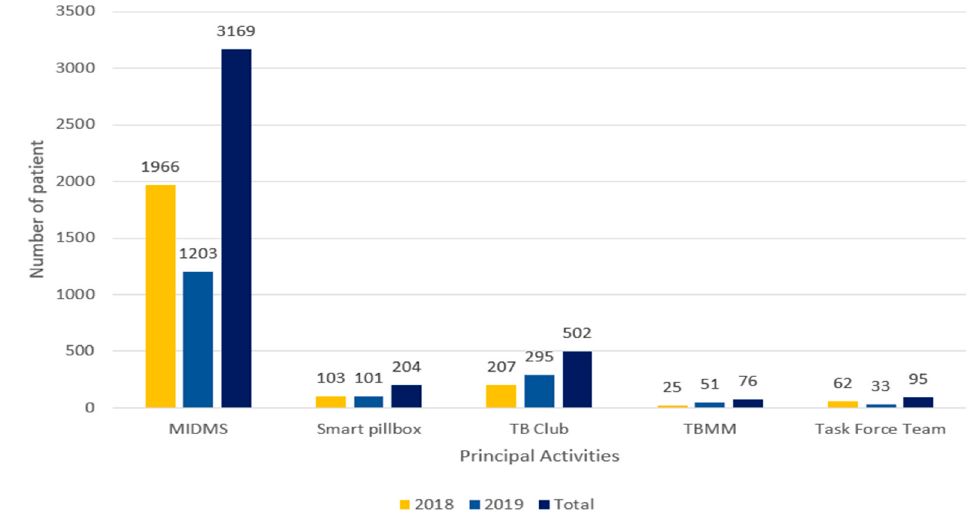
Figure 3. Project components related to treatment success.